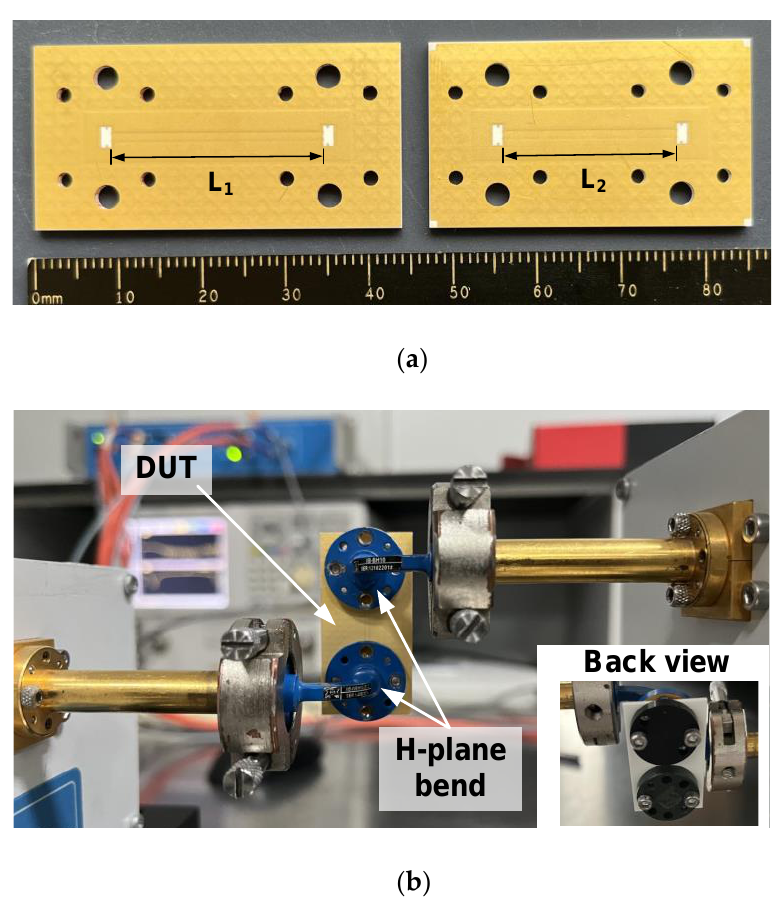
Figure 6. ( a ) Photograph of the fabricated back-to-back transitions. ( b ) Measurement setup. The simulated and measured results of two back-to-back transitions are given in Figure 7. From the different measured insertion loss of two transitions, the transmission loss of the LTCC laminated waveguide can be estimated. The insertion loss of the back-to- back transition can be calibrated by subtracting the transmission loss of the LWG line, half of which is the insertion loss of the single transition. The measured results demonstrate that the return loss is better than 14 dB in the range from 78 GHz to 101 GHz (25.7% bandwidth). The measured insertion loss of two back-to-back transitions with different length are, separately, 3 dB and 2.6 dB on average, and the transmission loss of the 10 mm LWG is calculated as about 0.8 dB. Therefore, it can be derived that the calibrated insertion loss of a single transition is about 0.5 dB in the operating band. The slight discrepancy between the simulation and the measured results may be due to the fabrication tolerance, assembly errors, and leakage wave caused by the waveguide gap. Compared with the previous LTCC works listed in Table 2, the proposed transition in this paper exhibits great bandwidth and low-loss performance without compromising structure